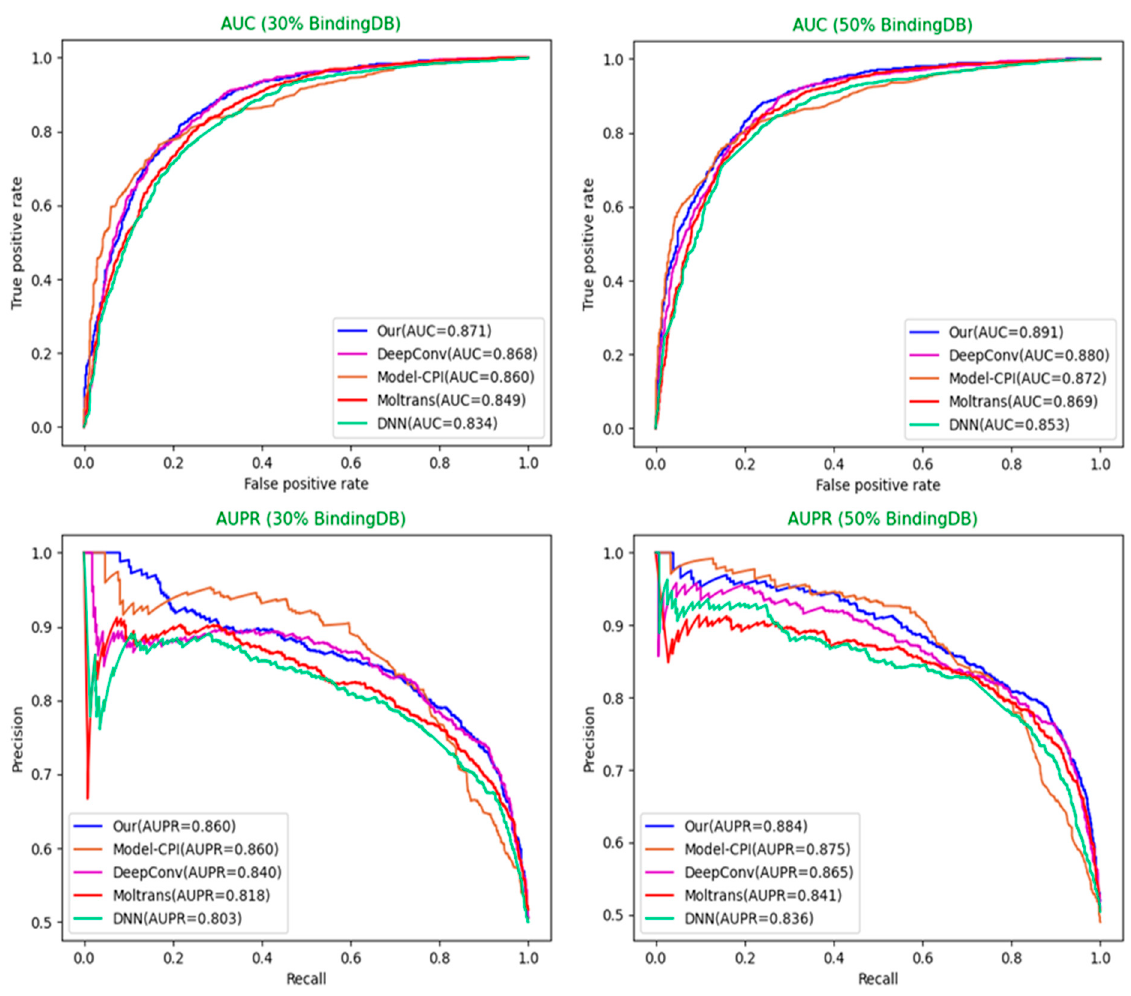
Figure 5. Model comparisons of AUC and AUPR on 30% and 50% BindingDB dataset (Our = MultiTrans-DTI).